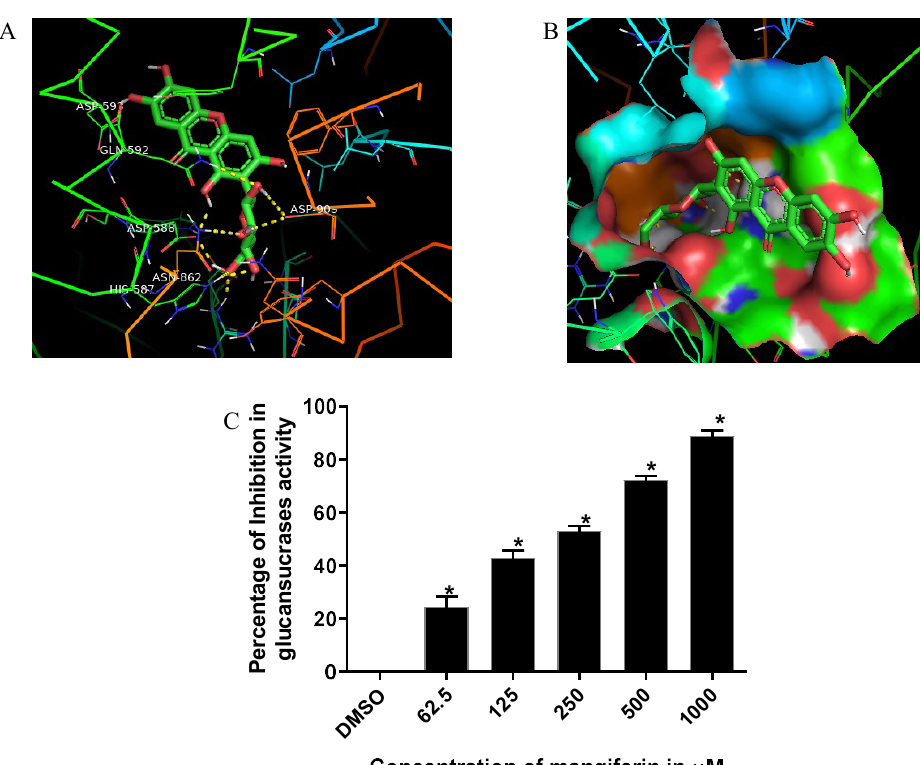
Figure 1. ( A ) Docked orientation of mangiferin to S. mutans glucansucrase (PDB ID: 3AIB); ( B ) Glucansucrase binding pocket representation for mangiferin in glucansucrase; ( C ) S. mutans glucansucrase inhibitory potential of mangiferin. The values are mean of three replicates ± standard deviations (SD). * p < 0.05, represents significant difference compared with the control group. Table 2. Hydrogen bond interaction of mangiferin and amino acid residues of S. mutans glucansucrase.